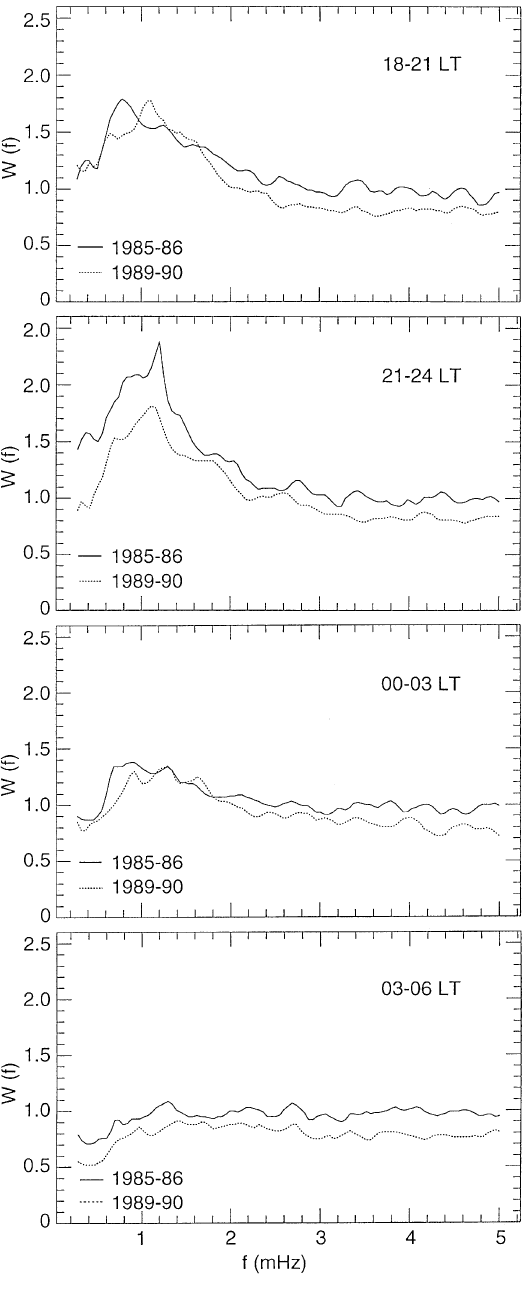
Fig. 3. The … ratio between the H and D spectral densities for the four 3-h nighttime intervals at minimum ( solid line ) and maximum ( dotted line ) of the solar